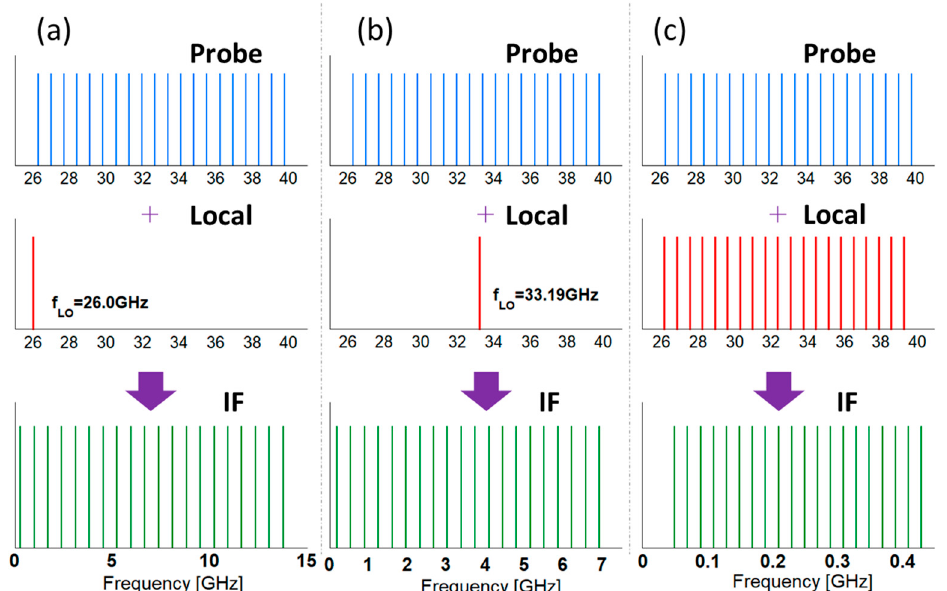
Figure 4. Schematic diagram of generating IF frequency. The blue (top), red (middle), and green (bottom) lines indicate the frequency components of probing comb, local, and IF, respectively. Here, frequency band of RF probe depicted as Ka-band. ( a ) Local frequency set outside RF frequency range. ( b ) Local frequency set near center RF frequency range. ( c ) Dual comb cases. Here, frequency difference between probe and local source drawn with 10 MHz shift.